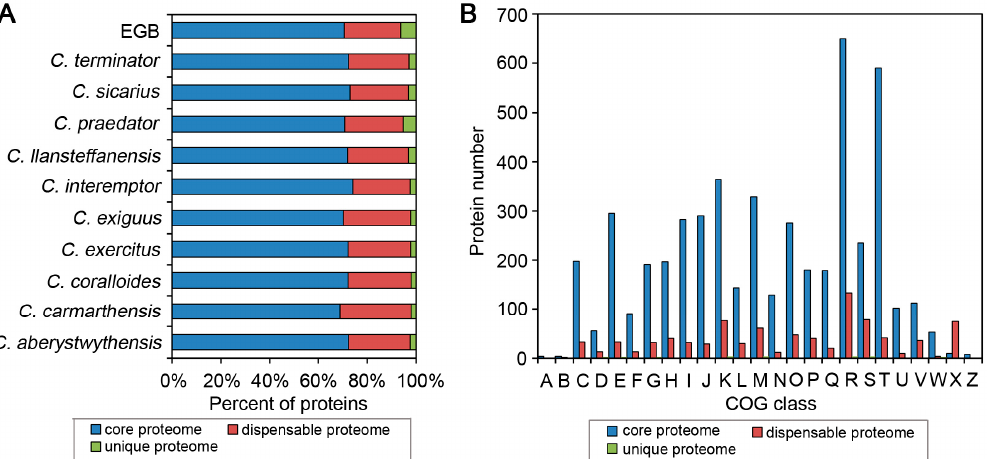
Figure 3. Comparative analysis of proteins between strain EGB and other Corallococcus species. ( A ) Number of protein families shared by different species. ( B ) Proportion of proteins enriched in the clusters of orthologous groups (COG) categories in the core, dispensable, and unique proteome. A, RNA processing and modification; B, chromatin structure and dynamics; C, energy production and conversion; D, cell-cycle control, cell division, chromosome partitioning; E, amino acid transport and metabolism; F, nucleotide transport and metabolism; G, carbohydrate transport and metabolism; H, coenzyme transport and metabolism; I, lipid transport and metabolism; J, translation, ribosomal structure and biogenesis; K, transcription; L, replication, recombination and repair; M, cell-wall/membrane/envelope biogenesis; N, cell motility; O, posttranslational modification, protein turnover, chaperones; P, inorganic ion transport and metabolism; Q, secondary metabolites biosynthesis, transport and catabolism; R, general function prediction only; S, function unknown; T, signal transduction mechanisms; U, intracellular trafficking, secretion, and vesicular transport; V, defense mechanisms; W, extracellular structures; X, mobilome: prophages, transposons; Z, cytoskeleton.